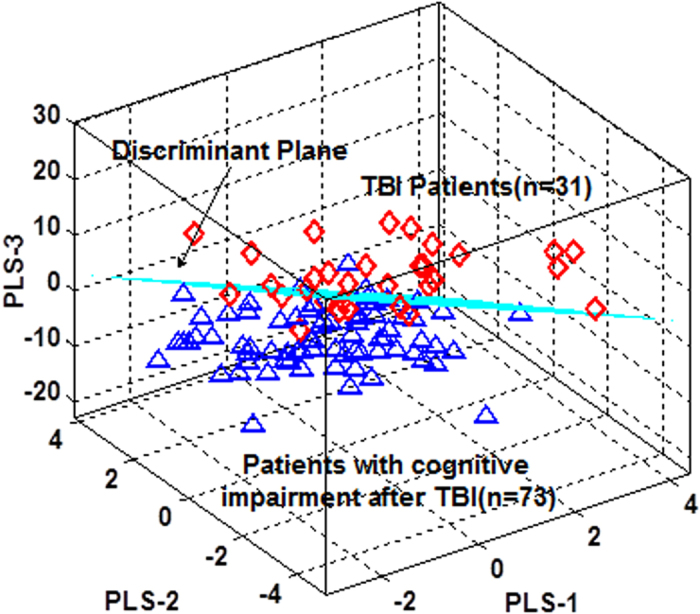
PLS-DA model to discriminate between TBI patients with and without cognitive impairment.